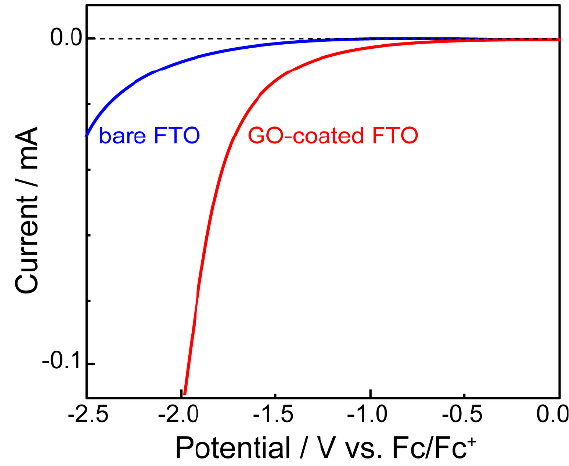
Figure 2. Linear sweep voltammogram of GO (red) (supporting electrolyte: 0.5 M Et 4 NBF 4 in propylene carbonate). As a reference, the LSV curve of bare FTO is shown (blue).